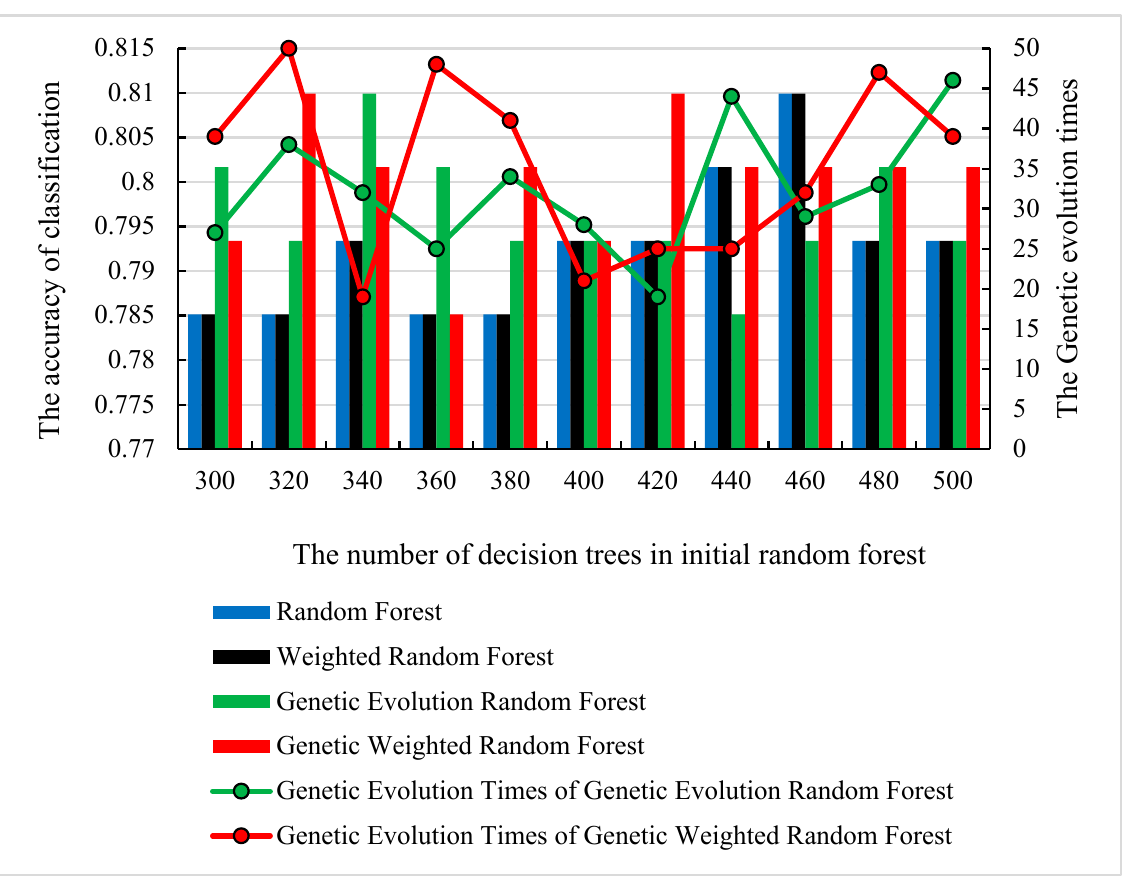
Figure 4. The optimal number of decision trees, genetic evolution times and their corresponding classification accuracy.